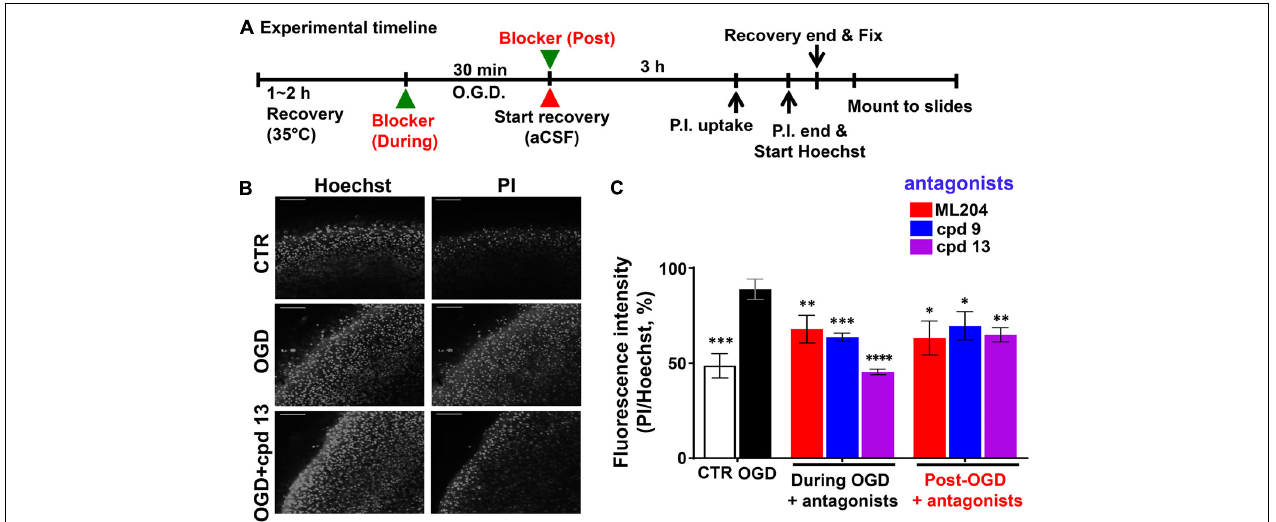
FIGURE 4 | Oxygen and glucose deprivation -induced neuronal death in the cerebral cortex of mouse brain slices. TRPC4/C5 blockers rescued OGD-induced neuronal death in the cerebral cortex of brain slices. (A) Schematic of the experimental timeline. (B) Representative images of Hoechst staining (left panels) and PI uptake (right panels) of acute brain slices (P15) from wild type (WT) mice without (CTR) or with OGD for 30 min in the absence or presence of TRPC4/C5 blocker, compound 13 (cpd 13). After the treatment, the slices were recovered for 3 h and stained with PI and Hoechst at 40 and 10 min, respectively, before the end of the 3 hr incubation. Scale bars, 100 µ m. (C) Summary data of PI/Hoechst fluorescence ratios (random unit, but the same settings used for all conditions). TRPC4/C5 blockers, ML204 (at 50 µ M), cpd 9, and cpd 13 (at 30 µ M) prevented the OGD-induced cell death to varying degrees no matter if they were added during or after (post) the OGD treatment. Data represent means ± SEM of n = 8 to 15 fields of view of independently treated slices. ∗ P < 0.05, ∗∗ P < 0.01, ∗∗∗ P < 0.001, ∗∗∗∗ P < 0.0001 vs. OGD without antagonist by Student t